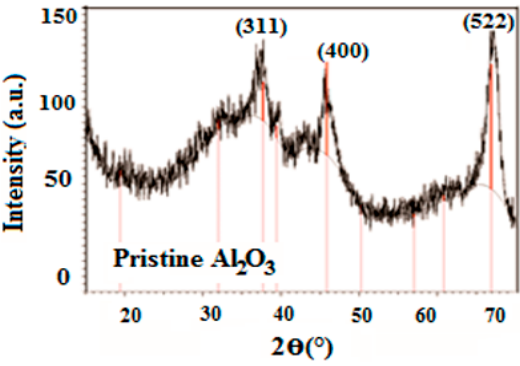
Figure 1. X-ray diffraction (XRD) pattern of pristine Al 2 O 3 nanopowder.